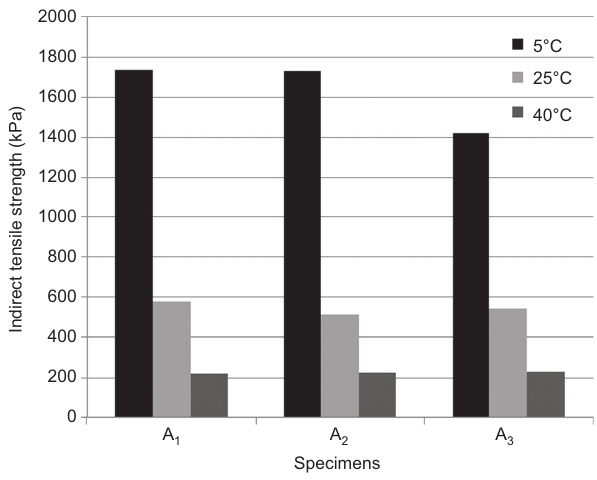
Figure 12 Variation of the indirect tensile strength of the A specimens.